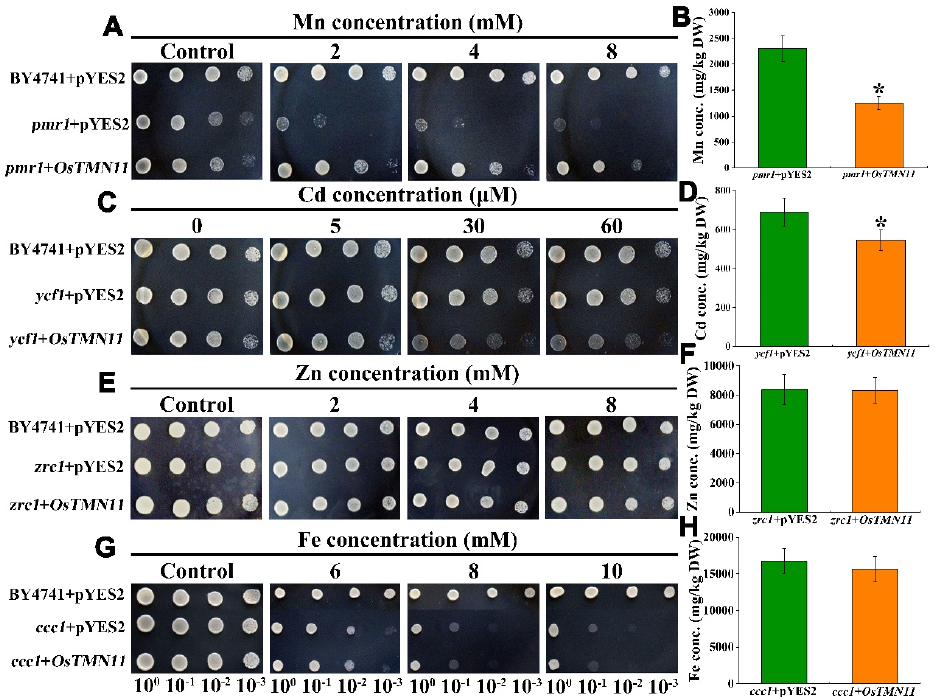
Figure 5. Measurement of transport activity of Mn, Cd, Zn, and Fe in OsTMN11 -transformed yeast cells. Wild-type strain (BY4741) and sensitive mutants ( pmr1 , ycf1 , zrc1 and ccc1 ) transformed with OsTMN11 and pYES2 empty vectors and were grown in YNB solid ( A , C , E , G ) and liquid SD-Ura ( B , D , F , H ) medium supplemented with Mn, Cd, and Zn, respectively. All treated yeast cells were digested. The metal concentrations in the cells were quantified using inductively coupled plasma mass spectrometry. Error bars indicate the means ± standard deviations of three biological replicates. Asterisks indicate that the mean values are significantly different between the treatment and control or between the empty and transformed cells ( p < 0.05).